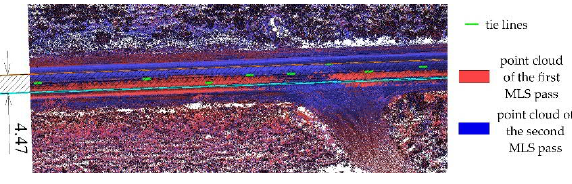
Figure 4 . An example of identified tie lines.